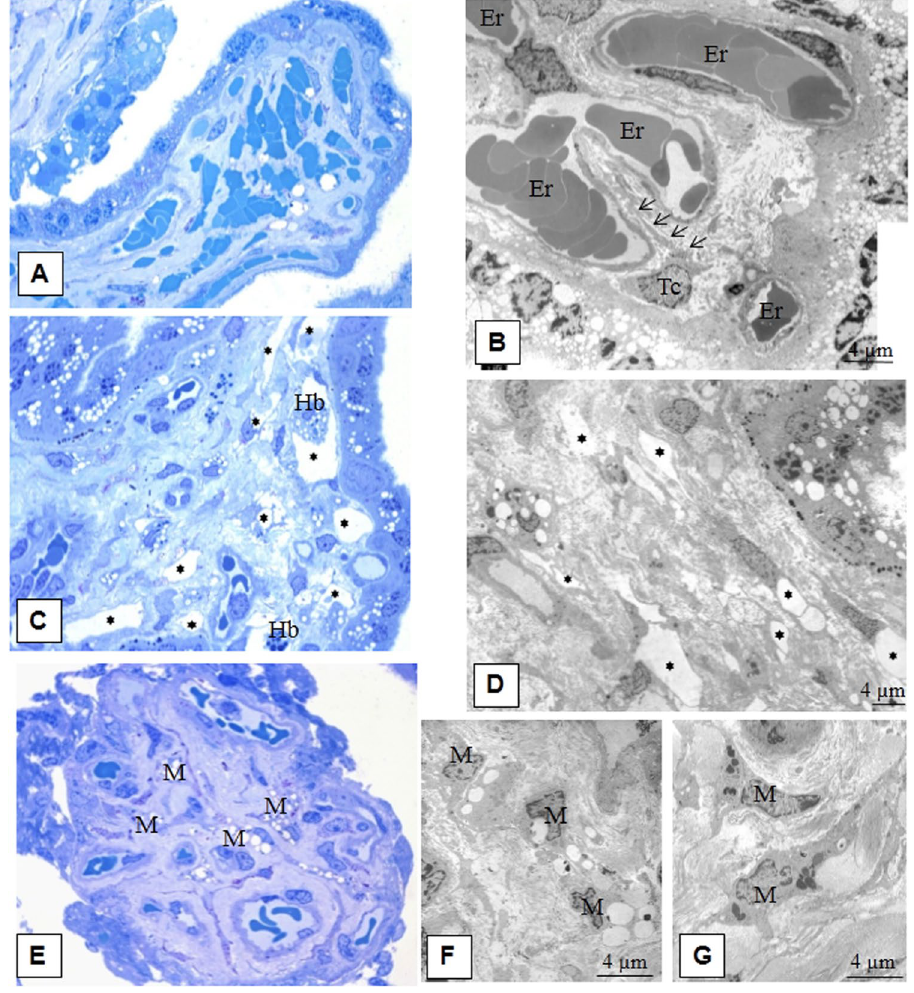
vacuoles. Semithin section, × 400. ( F ) Macrophages (M) with vacuoles. Electron microphotograph, × 4800. ( G ) Macrophages (M) with residual bodies. Electron microphotograph, ×